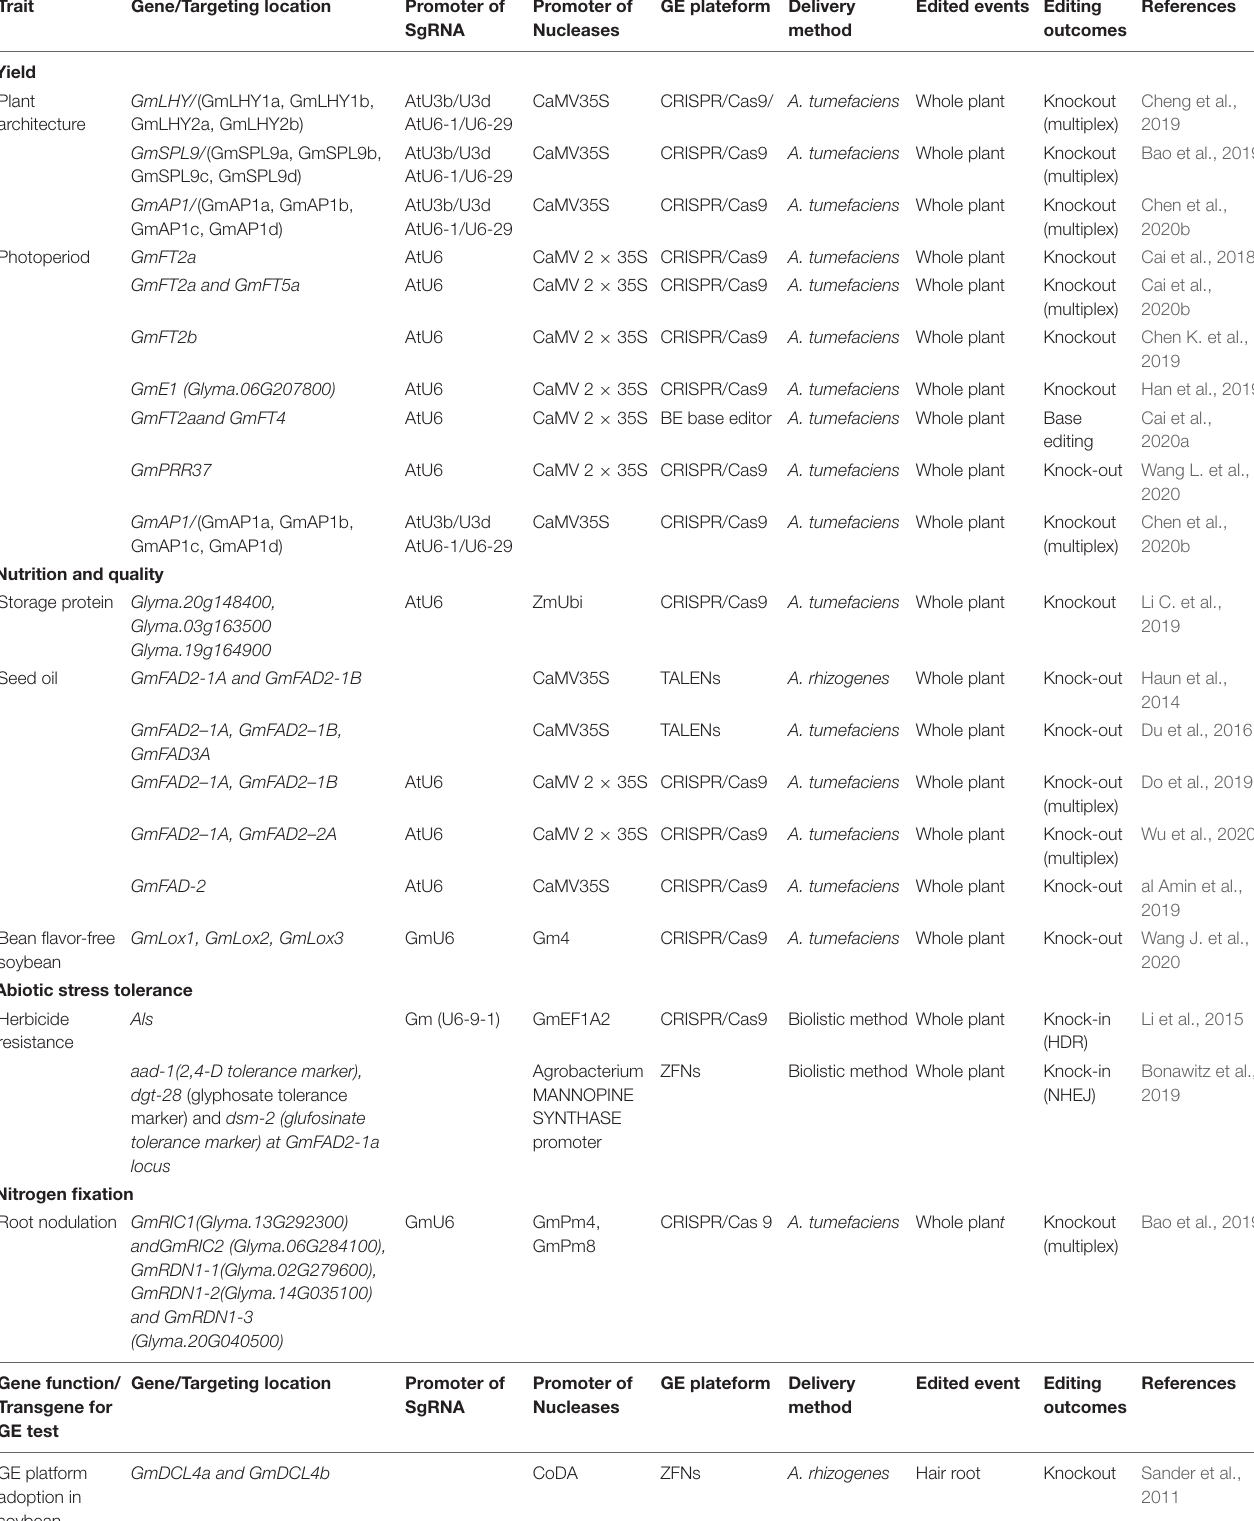
TABLE 2 | List of soybean genes edited for functional genetics study and trait improvement using genome editing technology. Trait Gene/Targeting location Promoter of